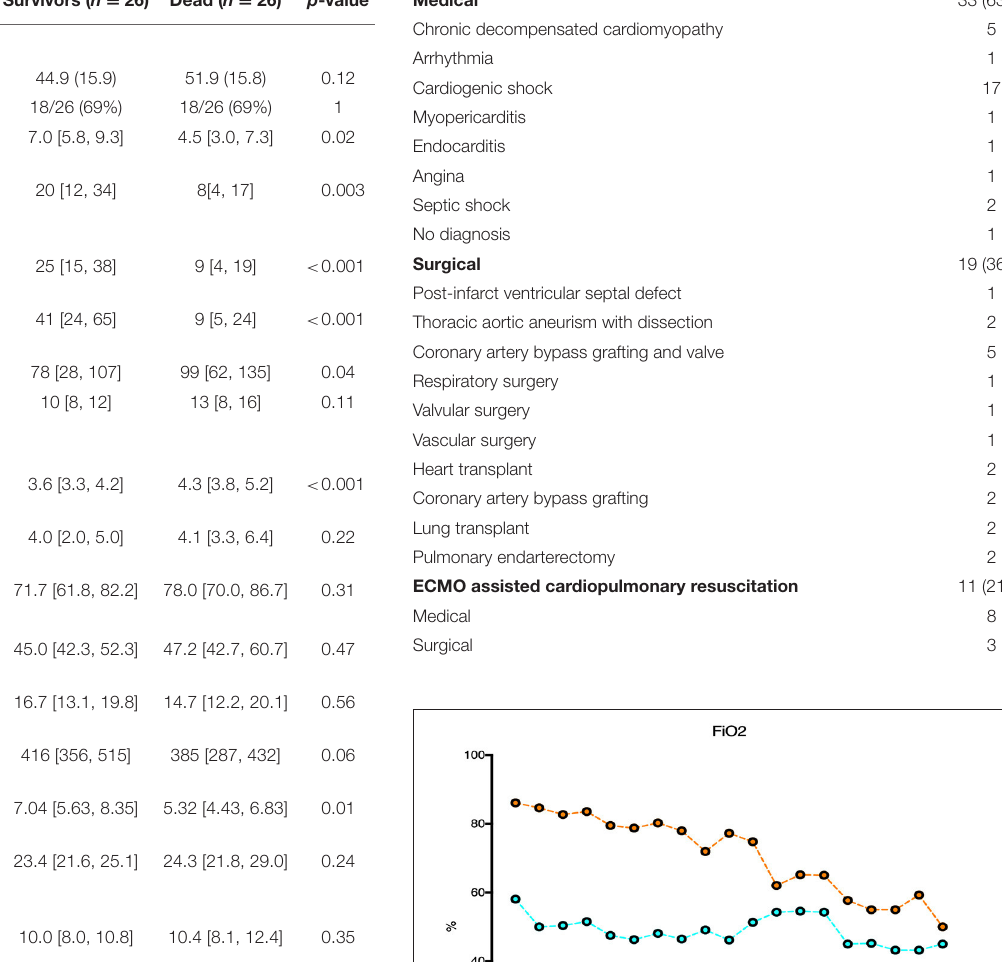
TABLE 1 | Baseline demography, ECMO support, and ventilation characteristics. Variable